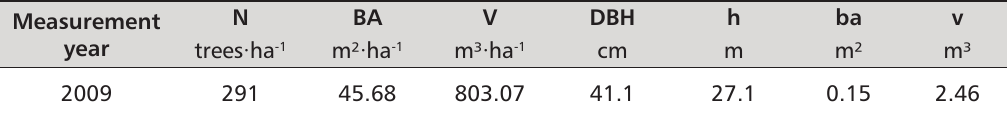
TABLE 1. Basic stand structure elements (stem number – N, basal area – BA, volume – V) and average values (diameter at breast height – DBH, height – h, basal area – ba, volume – v) of the beech trees of the experimental plots in Measurement